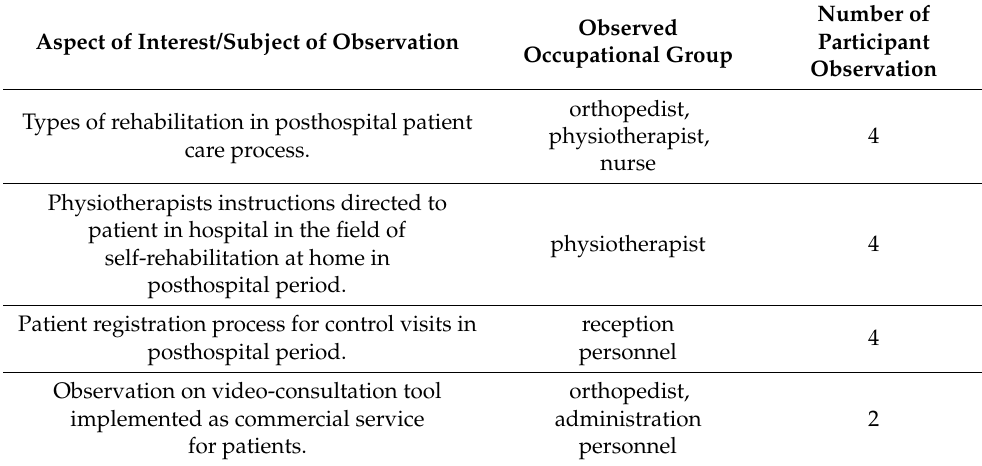
Table 1. Aspects of interest in participant